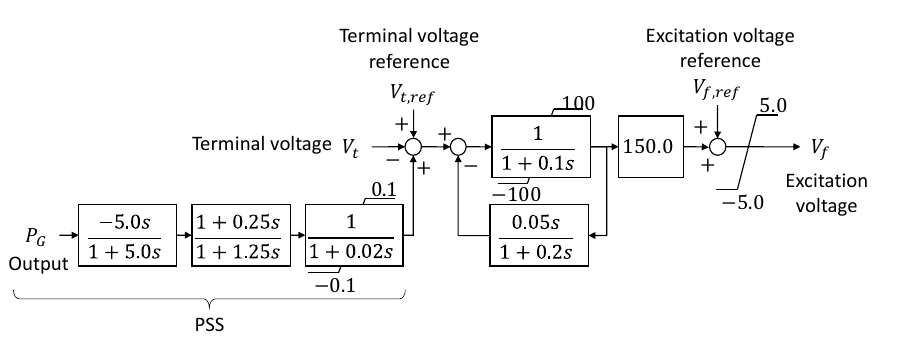
Figure 2. Speed governor and turbine model.